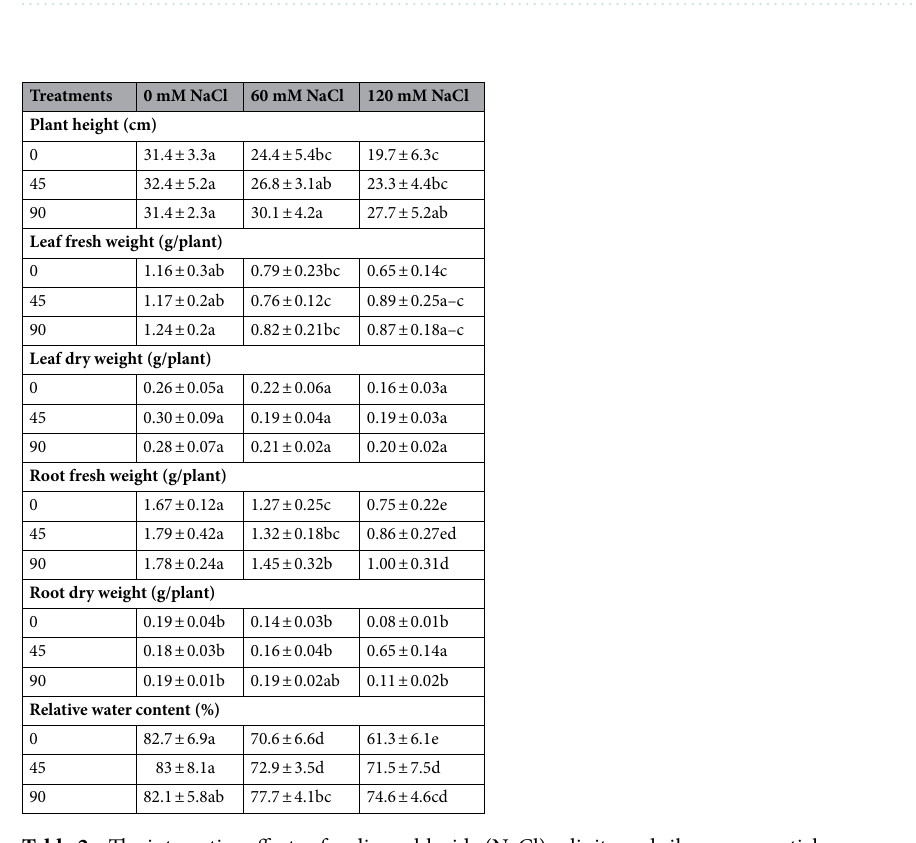
Table 1. The interactive effect of salinity stress and green nanoparticle on seed germination in Roselle.